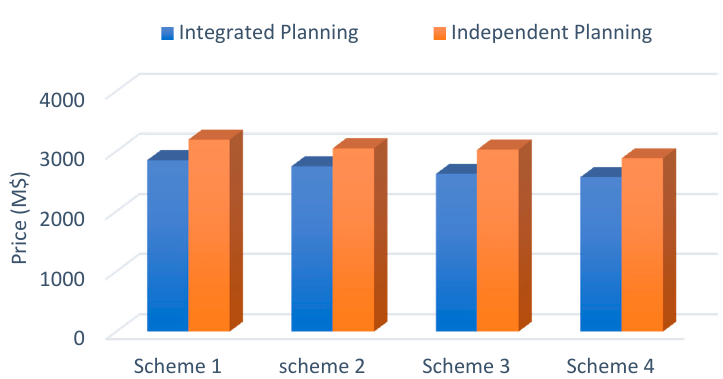
Figure 8. Comparison of total planning cost of both case studies.